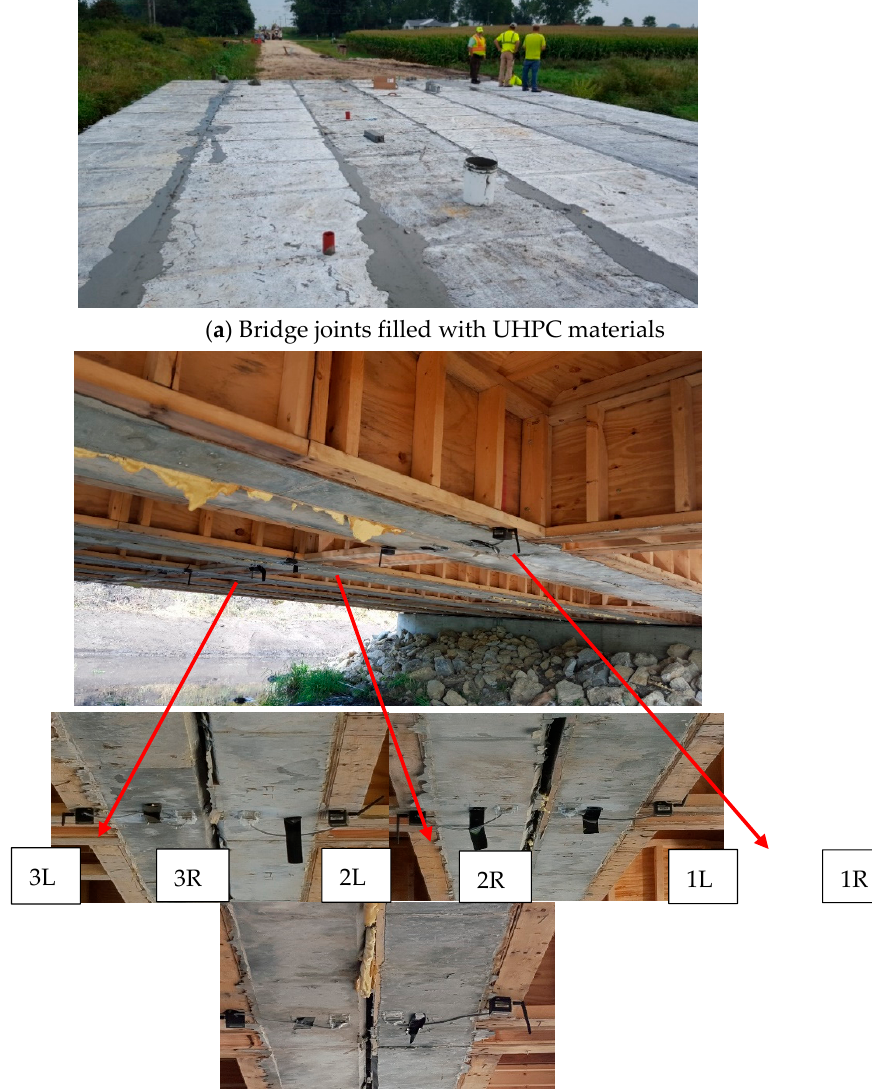
Figure 10. Six SenSpot strain sensors installed on three joints.